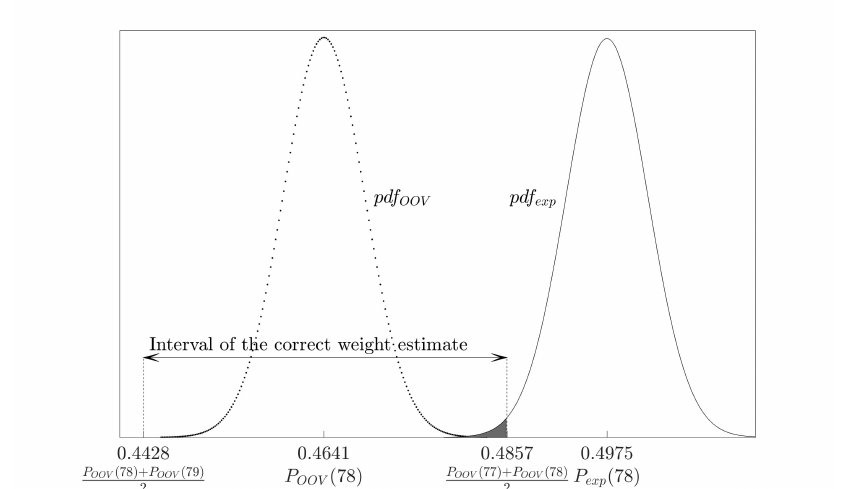
(cid:18) (cid:19) P exp ( 78 ) ( 1 − P exp ( 78 ) ) P exp ( 78 ) , follows the distribution N , n n (cid:18) (cid:19) ( 78 )( 1 − P OOV ( 78 )) P OOV ( 78 ) , P OOV ; the application of n n Formula